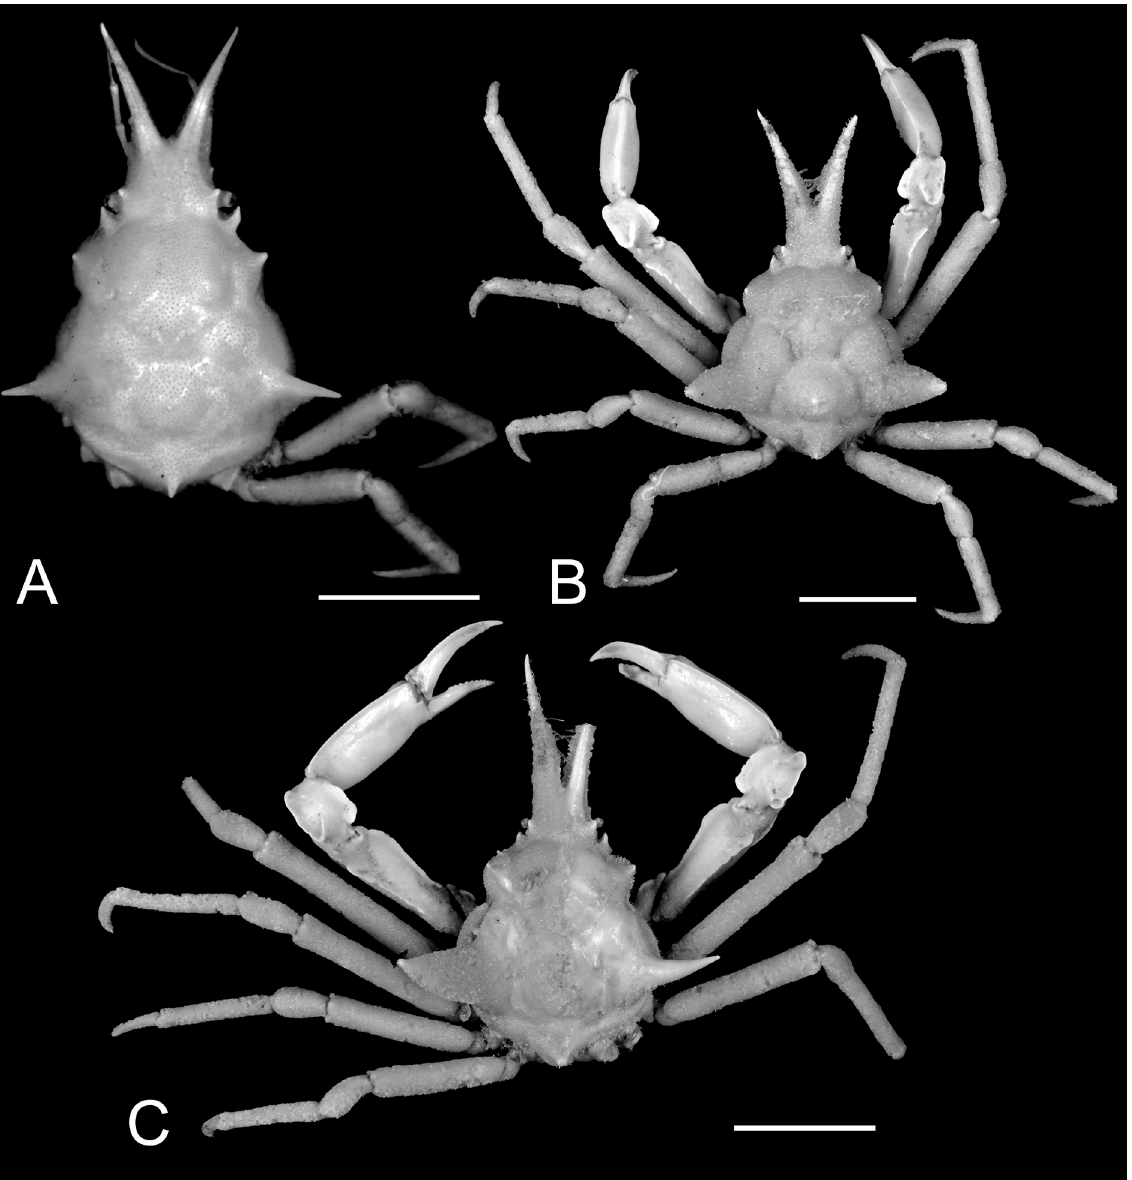
Fig. 12. Rochinia debilis Rathbun, 1932, overall dorsal view. A . Holotype, ♀ (10.8 × 7.0 mm) (USNM49572), Japan. B . ♂ (23.1 × 15.8 mm) (SMF49904), Japan. C . ♂ (28.9 × 21.0 mm) (SMF49905), Japan, carapace half cleaned. Scale bars: A = 5 mm; B–C =